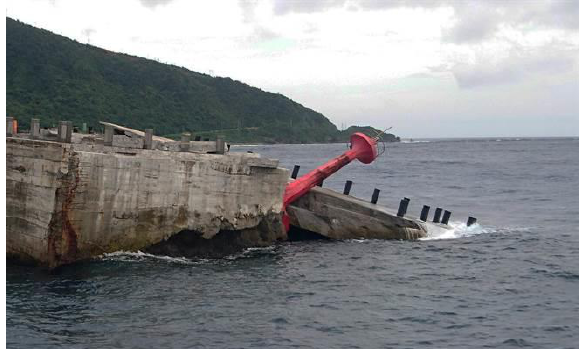
Figure 1. A lighthouse destroyed by a Typhoon Meranti (2016)-induced roaring wave (Photo source: http://www.chinatimes.com/).